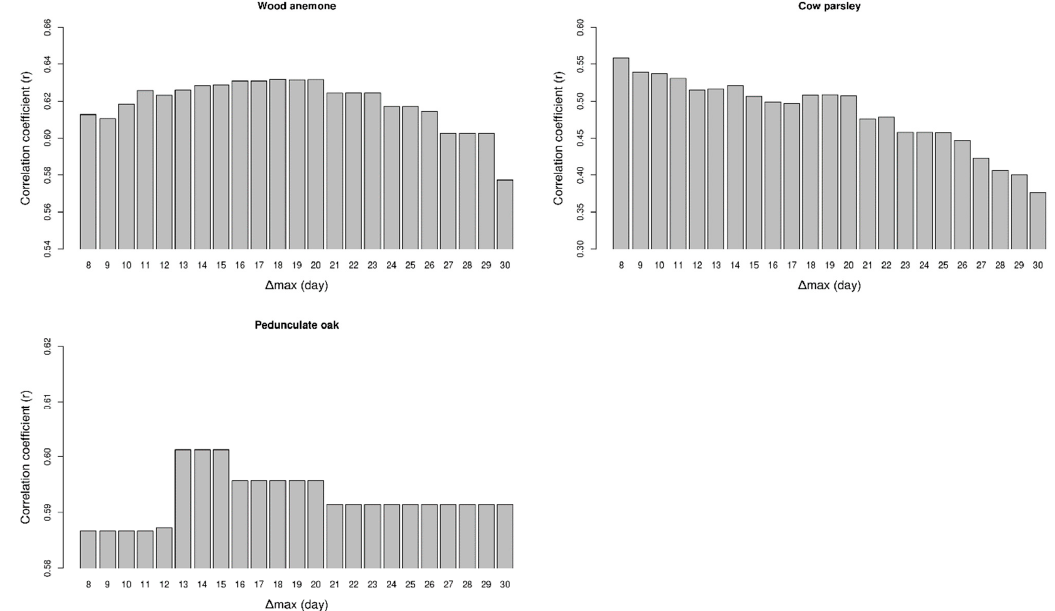
Figure A7. Correlation coefficient (r) between the standard deviation of the reported DOYs for the flowering onset of wood anemone, cow parseley and pedunculate oak and the average GDD for ∆ Max values varying from one week to 30